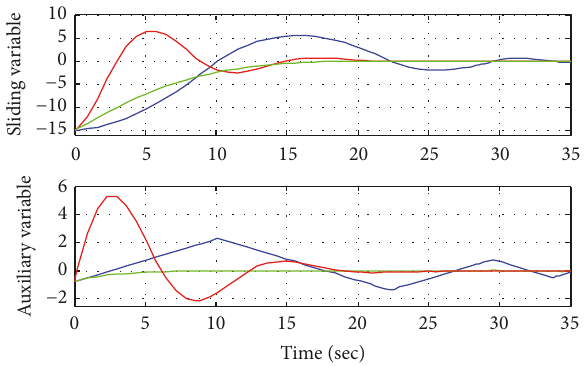
Figure 1: Dynamic of the sliding variable and the auxiliary variable with different structures of STA (blue line: the classical STA, red line: the modified STA, and green line the novel modified STA).